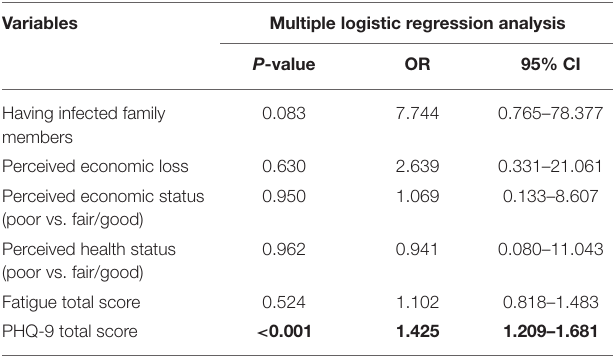
TABLE 3 | Multiple logistic regression analysis of factors independently associated with PTSS among COVID-19